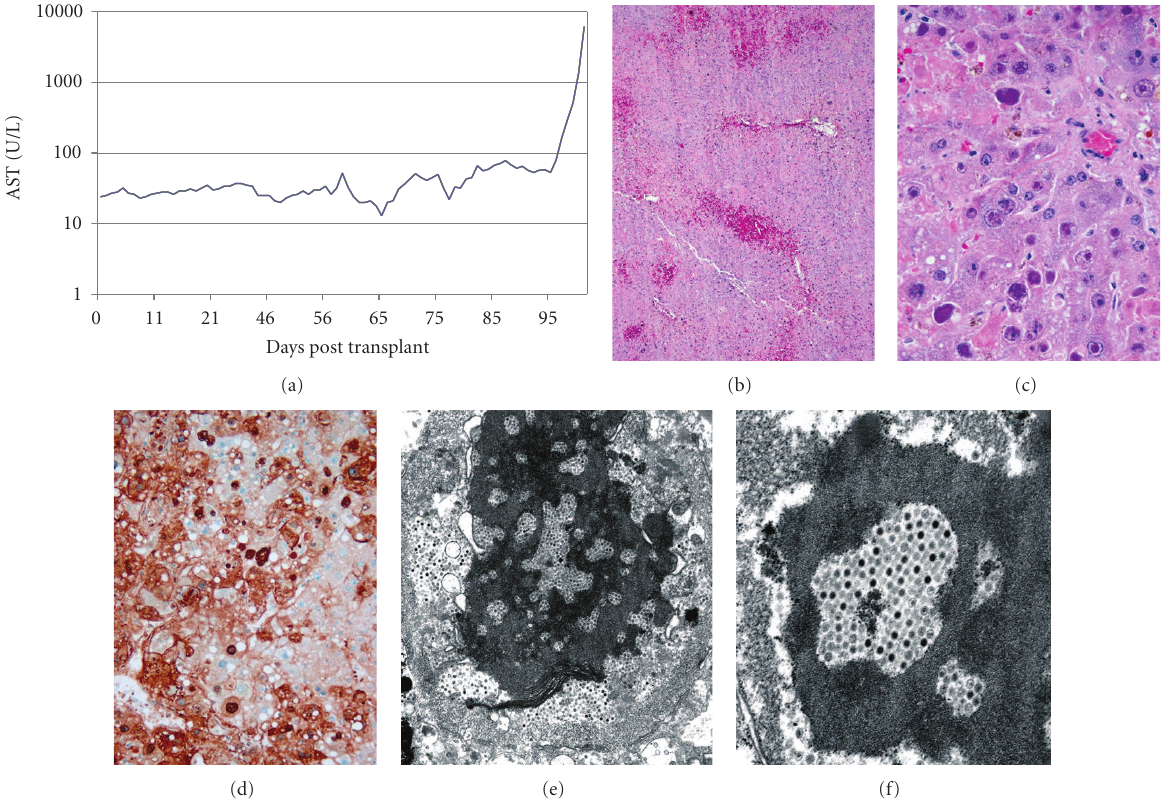
Figure 1: (a) Time course of AST elevation after allogeneic transplant, (b) hepatic necrosis with intraparenchymal hemmorhage (H & E, 4x), (c) hepatocyte nuclei with marked variation in size, with intranuclear inclusions (H & E, 40x), (d) immunohistochemistry stain—positive for adenovirus (40x), (e) electron micrograph of intranuclear adenovirus particles (14,000x), (F) high-resolution electron micrograph image of adenovirus particles